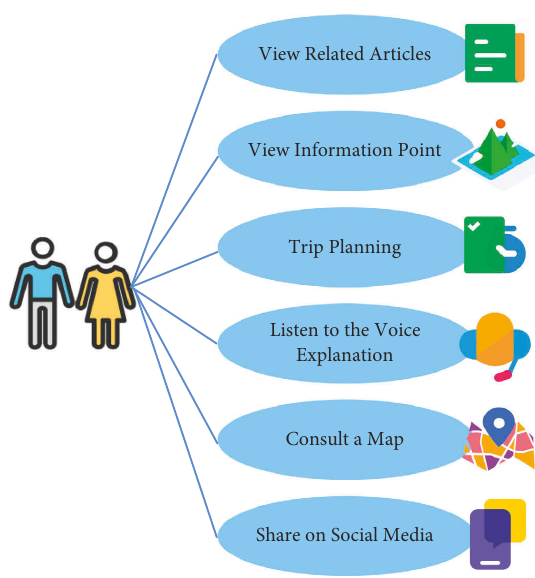
Figure 2: Service demand use case during and after